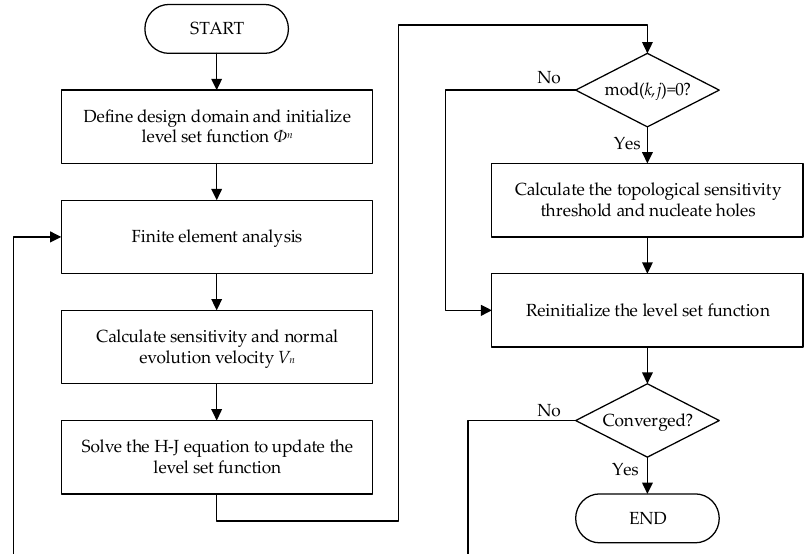
Figure 1. Flowchart of the level set topology optimization combining BESO and topological sensi-